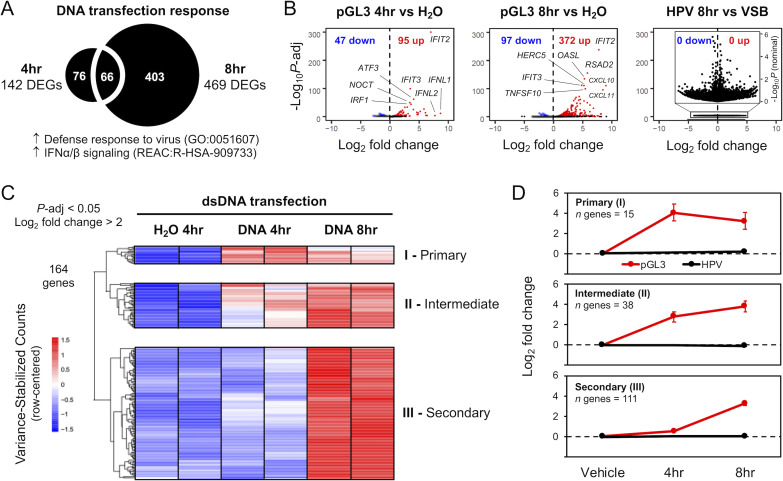
HPV16 virion infection does not activate cellular responses to dsDNA.RNA-seq was used to transcriptionally profile cellular responses to pGL3 DNA introduced via liposome transfection or HPV virion infection. (A) Relative to H2O mock-transfection, there were 142 significantly (P-adj < 0.05) differentially expressed genes (DEGs) at 4hr and 469 DEGs at 8hr post-transfection, with up-regulated genes functionally enriched for biological processes and pathways related to defense responses to virus and IFN signaling. (B) Volcano plots for 4 and 8hr pGL3 transfections (n = 2) show significantly DEGs (P-adj < 0.05), with up-regulated genes (red) related to strong innate immune signaling responses. No response was activated 8hr following HPV virion infection (n = 3) relative to viral storage buffer (VSB); inset volcano plot is re-scaled, using nominal (unadjusted) P-values, to show distribution of genes that do not reach significance. (C) Heatmap of variance-stabilized counts, row-centered, for the top up-regulated cellular response genes (P-adj < 0.05, log2 fold change > 2, for 4 and 8hr pGL3-transfection: 164 genes). Genes clustered into three main groups, corresponding to temporal responsiveness post-transfection: cluster I (immediate/primary response at 4hr), cluster II (intermediate response at 4 and increasing at 8 hr), and cluster III (secondary response at 8 hr). (D) Metagene log2 fold change values were computed by aggregating response data of all genes within each cluster. Error bars represent 95% confidence intervals for each gene cluster.